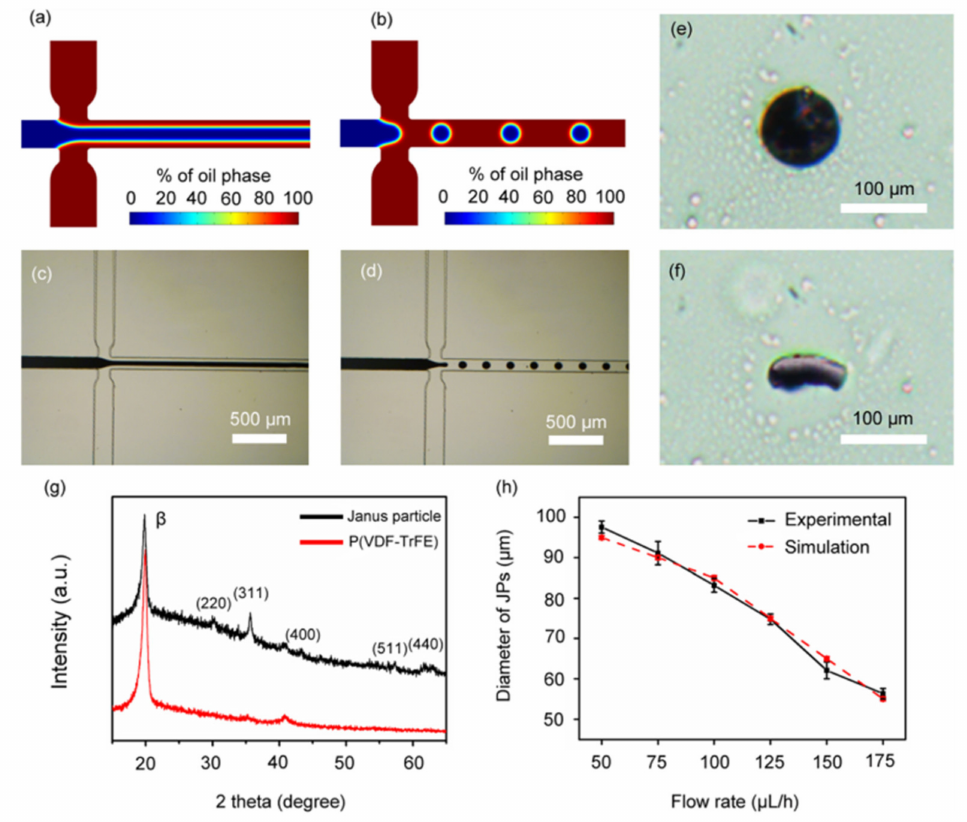
Figure 6. ( a – d ) Simulation and experimental images of the laminar flow and the microfluidic device. ( e , f ) Sample images of a disk-like Janus particle. ( g ) XRD analysis of the synthesized particles. ( h ) Simulation and experimental results for the particle diameters at various flow rates. Reprinted with permission from X. Yu, et al., 2016 Applied Physics Letters 108, 073504 [72]. Copyright